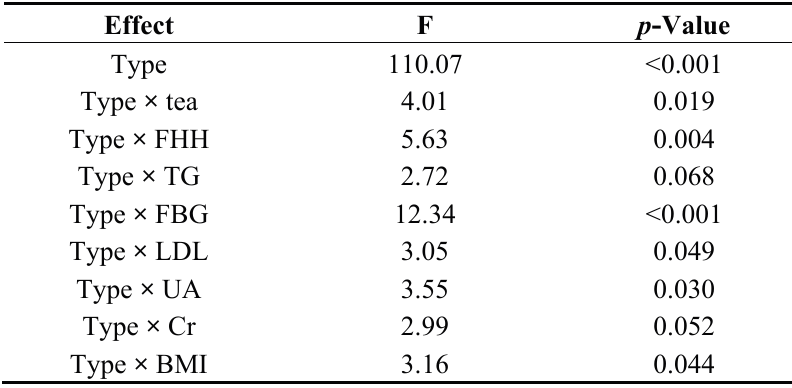
Table 5. The fixed effects test of analysis of the impact factors of different types of